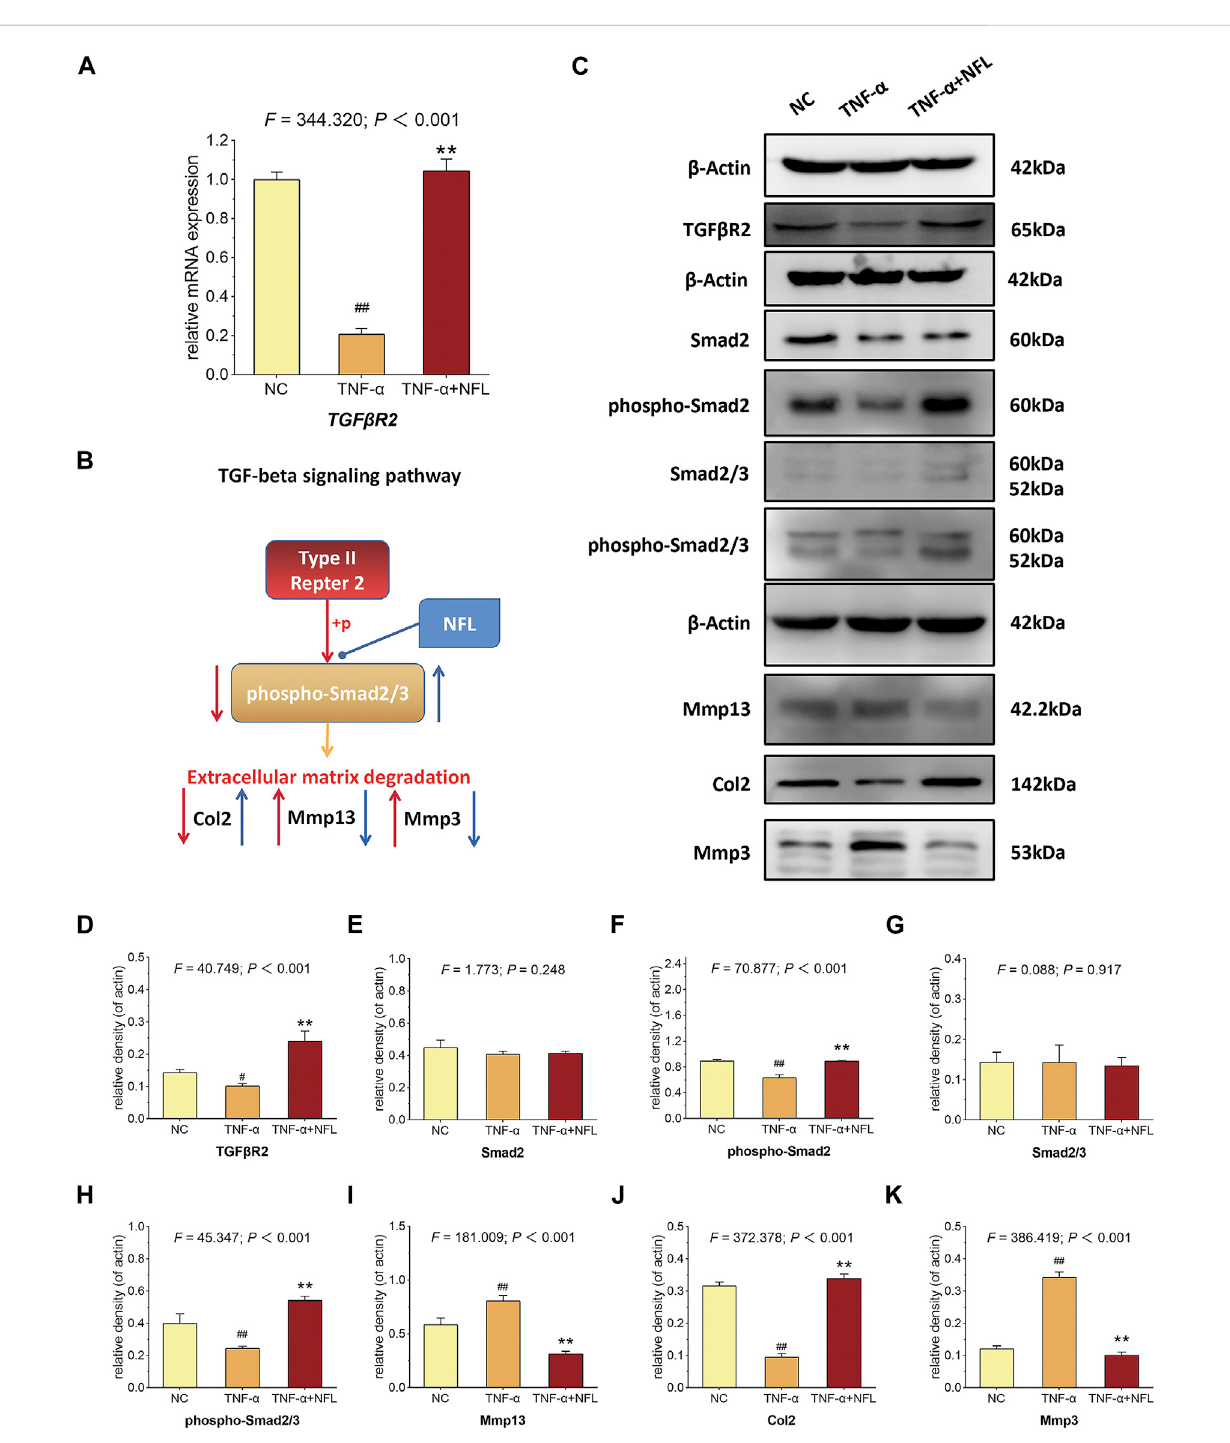
FIGURE 6 qPCRveri fi cationandWesternblotanalysisofchondrocytesinTGF- β – Smad2/3signalingpathway. (A) TherelativemRNAexpressionof TGF β R2 wastested to verify the RNA-seq result; (B) deduction of TGF- β – Smad2/3 signaling – mediated mechanism; (C) Western blot assay of indicated proteins and the statistical analysis of relative density for (D) TGF β R2, (E) Smad2, (F) phospho-Smad2, (G) Smad2/3, (H) phospho-Smad2/3, (I) Mmp13, (J) Col2 and (K) Mmp3. # p < 0.05